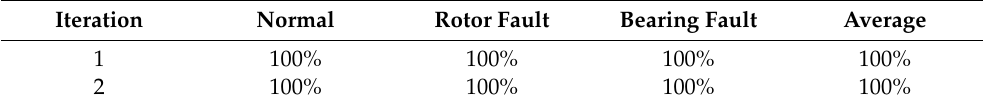
Table 6. Diagnostic accuracy of convolutional neural network for cross-validation. Iteration